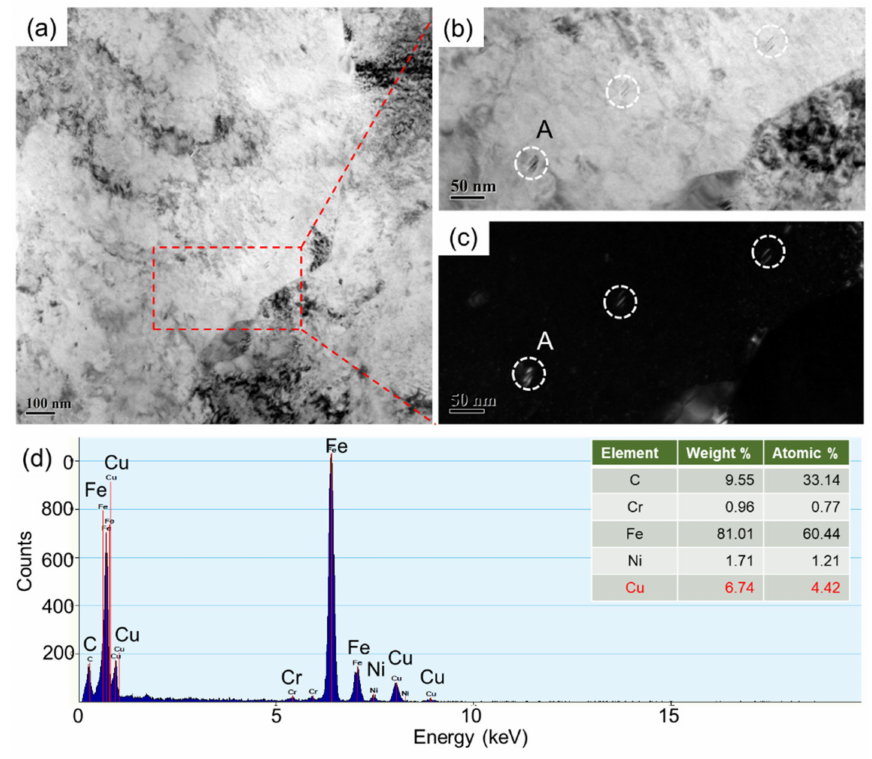
Figure 6. The distribution of Cu-containing precipitates observed by TEM ( a ). The bright field image ( b ) and the dark field image ( c ) shows the morphology and the size of precipitates. The EDS analysis on the precipitate A in ( b ) verifies the Cu-rich in these precipitates ( d